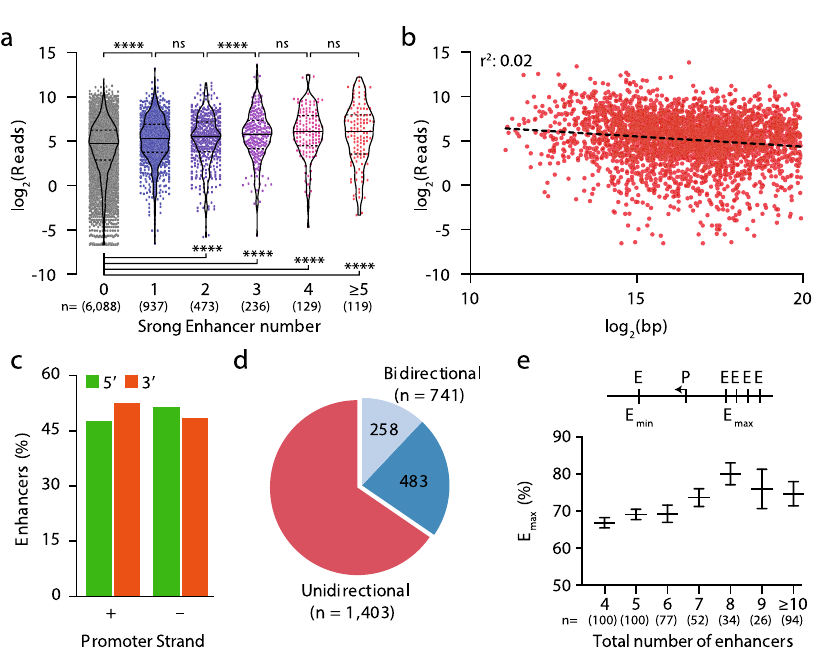
Fig. 5 Enhancers show directional organization. a S3 nascent expression (4sU-seq) of genes interacting with elements identi fi ed as being strong enhancers by GenoSTAN. **** p < 0.0001, nonsigni fi cant (ns), one-way ANOVA with Sidak ’ s multiple comparison tests. b S3 nascent expression of genes plotted against closest enhancer element. Line shows linear regression, r 2 values is for Pearson correlation ( r = − 0.146, p < 0.0001). c Distribution of enhancer location (5 ’ or 3 ’ ) based on promoter strand ( + or – ). d Number of promoters with multiple enhancers where the enhancers are all upstream or downstream (unidirectional: co-location) or a mixture of upstream and downstream (bidirectional). Bidirectional promoters with two or three enhancers ( n = 258) are distinguished from those with four or more enhancers ( n = 483) by light and dark blue, respectively. e Percent of enhancers on the side with the most enhancers ( E max ) at bidirectionally interacting promoters. Bars show standard error of the mean. n = number of promoters. Source data are available in the Source Data fi